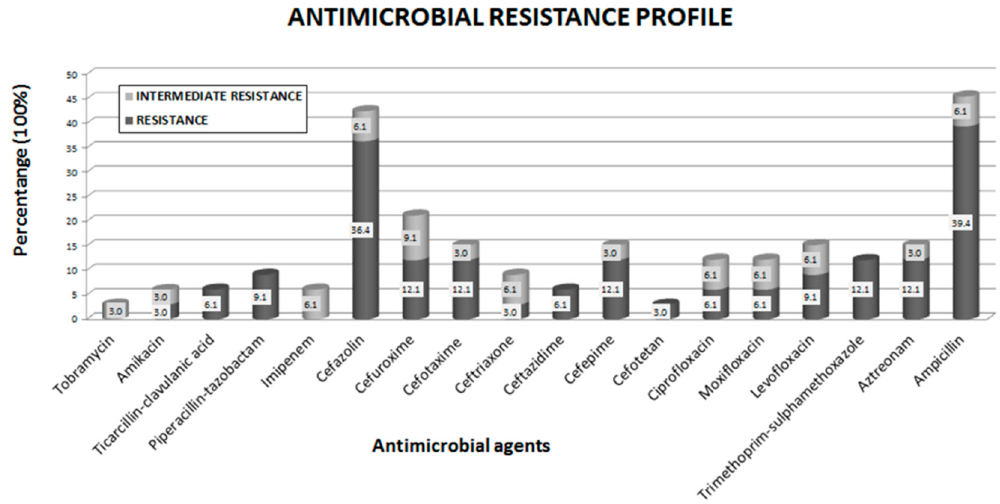
Figure 4. Antibiotic resistance profiles (%) among the isolates from samples collected during 2013 and sampling sites in the Bassaseachic Falls National park, Ocampo, Chihuahua, Mexico, using the AutoScan ID panel database.